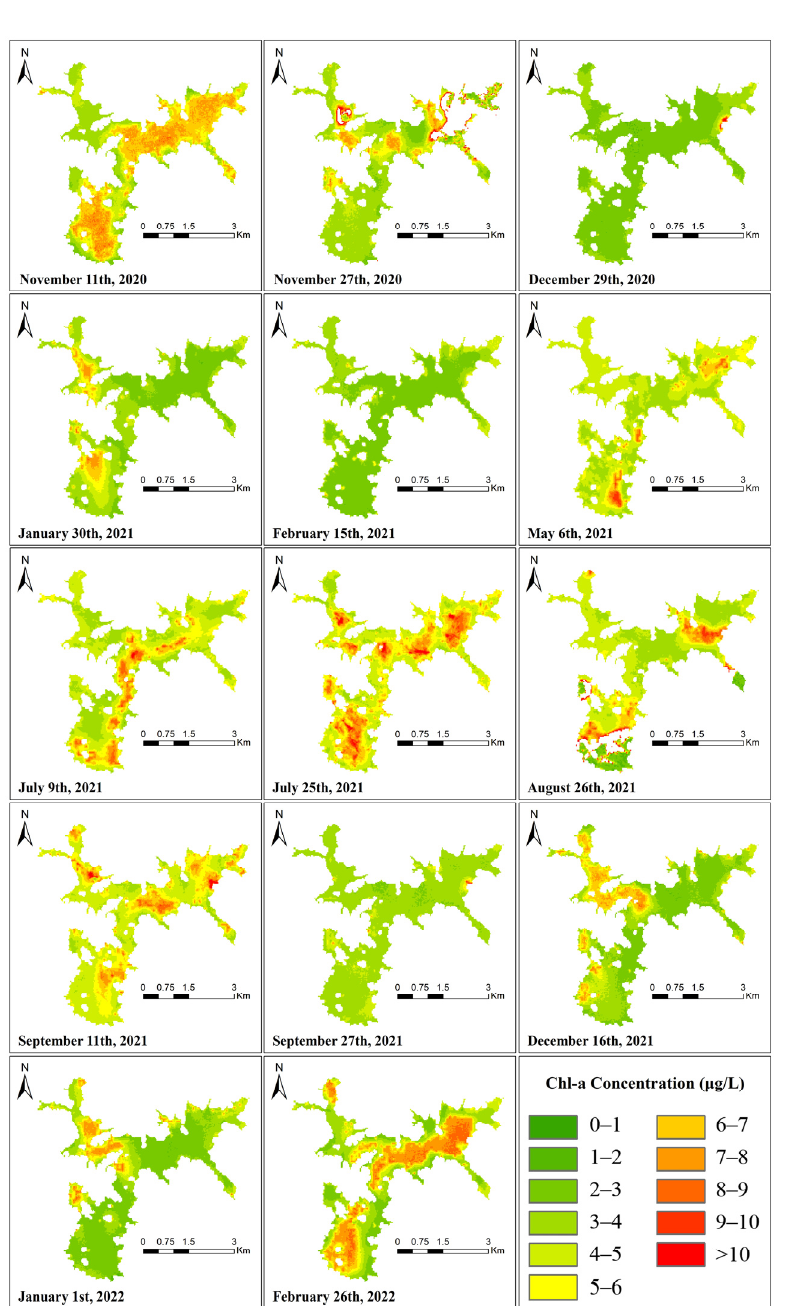
Figure 8. Spatial distribution of Chl-a concentration from Landsat OLI data.